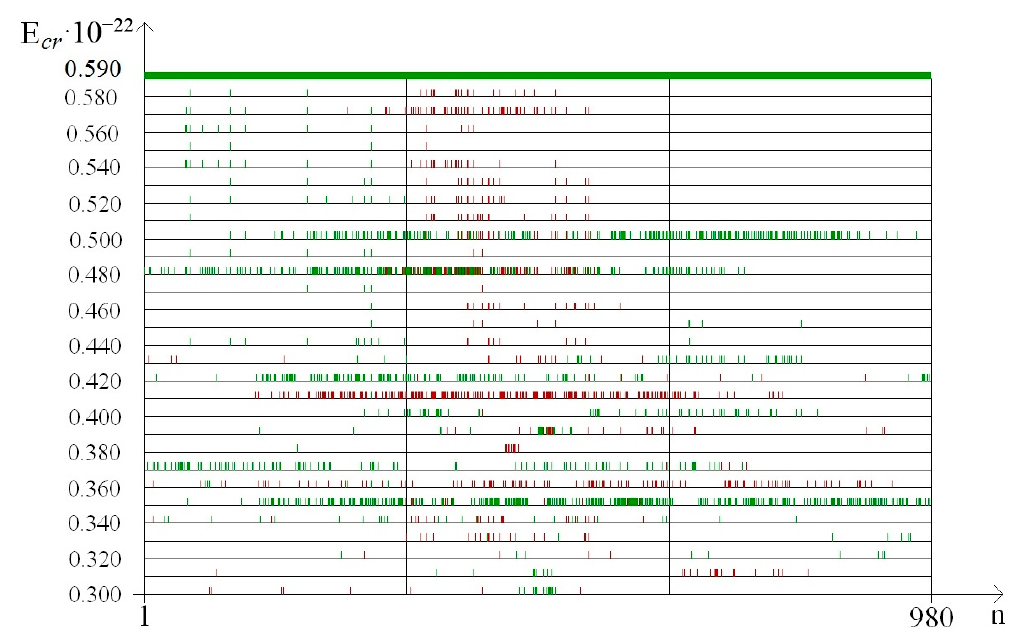
Figure 4. Distribution in the different parts of IFNA17 of nucleobase pairs (which was counted by quartile method) leading after the single 2 H/ 1 H replacement the extreme frequency of OS occurrence. Note: red dot is the location of the deuterium atom in the DNA molecule, which leads to the maximum probability of OS occurrence (range); green dot is the location of the deuterium atom in the DNA molecule, which leads to the minimum probability of OS occurrence (range).